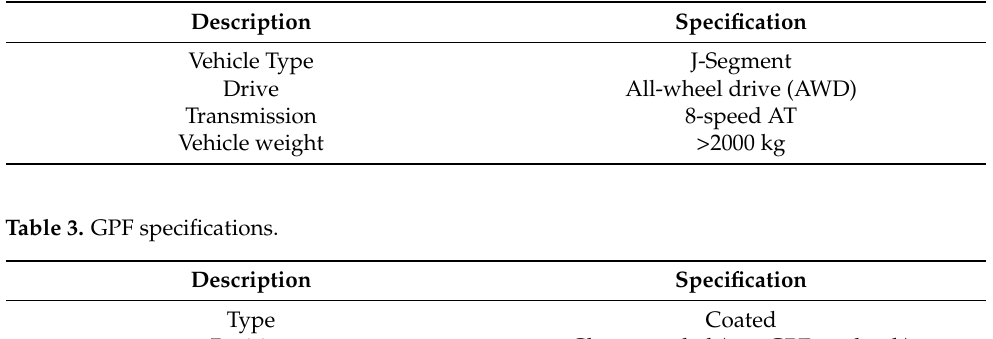
Table 2. Reference vehicle specifications.